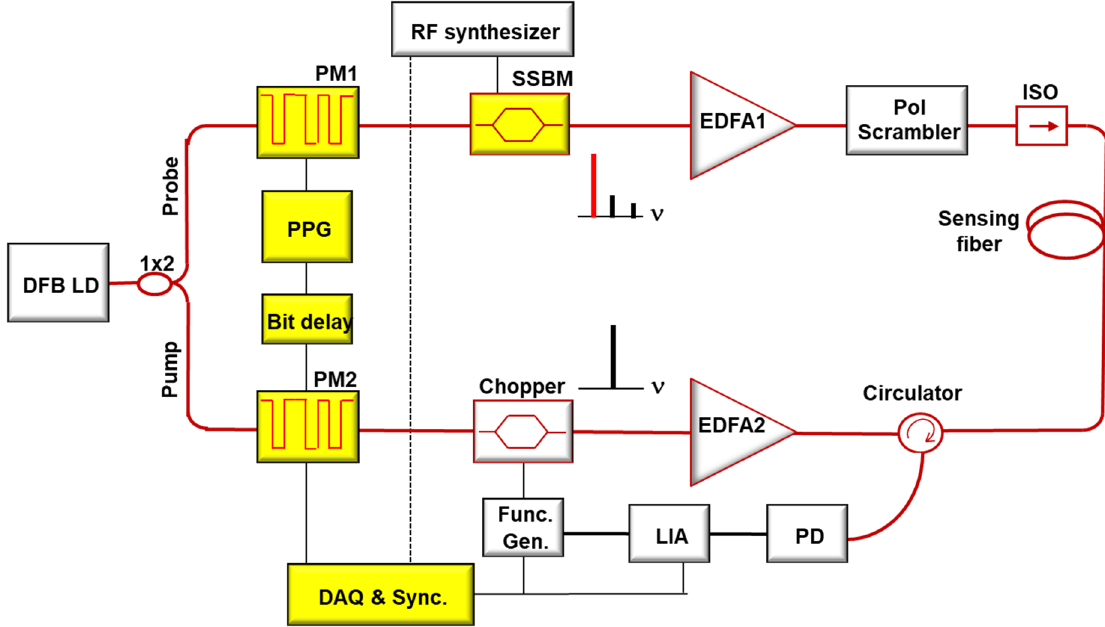
Figure 2. Experimental setup of the TD-BOCDA sensor measurement system with a sensing optical fiber.